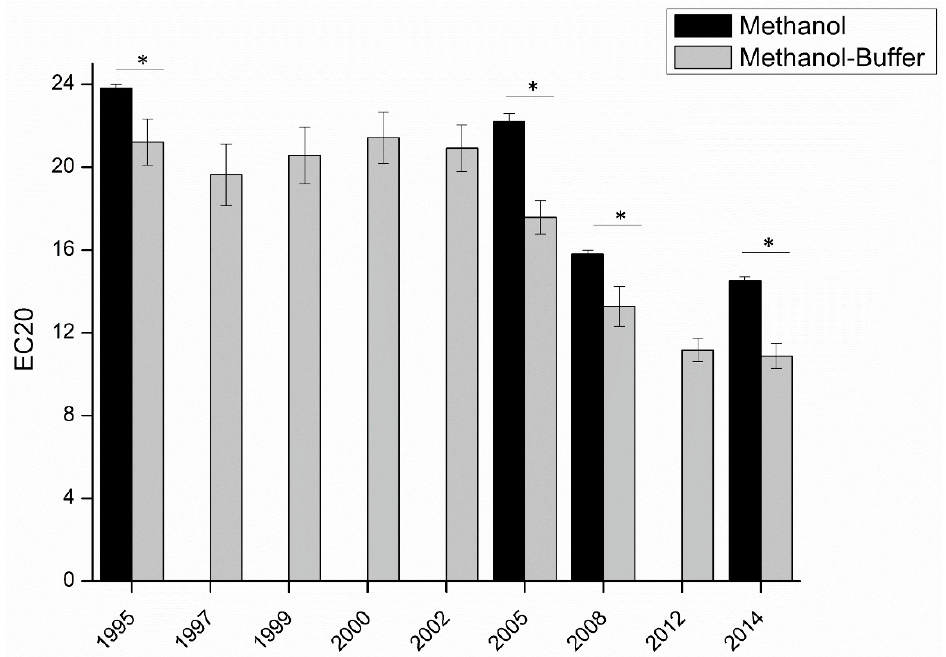
Figure 4. Comparison of the antioxidant capacity of the same appellation from nine vintages from the same winery. Measurements in methanol ( (cid:4) ), and in methanol-buffer ( (cid:4) ). Student tests show comparison between methanol and methanol-buffer methods, “*” indicate significant difference ( p < 0.05).